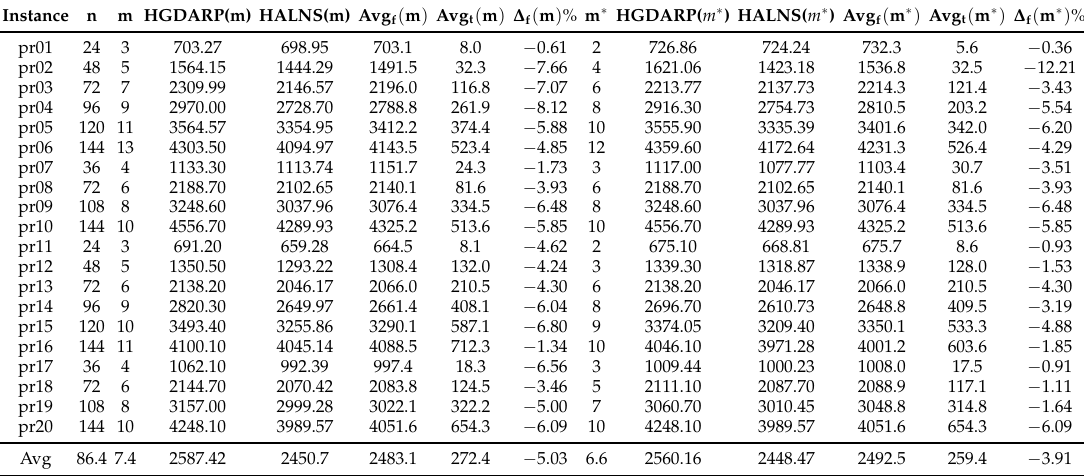
Table 2. Duration minimization